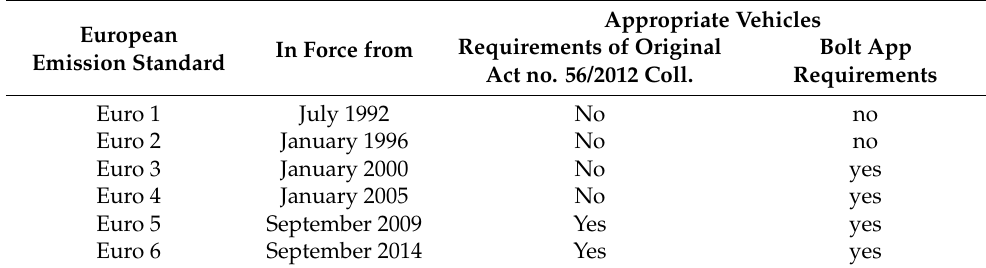
Table 7. Taxi vehicles appropriate for taxi operation according to their emission standard. Processed by the author from the source [40].